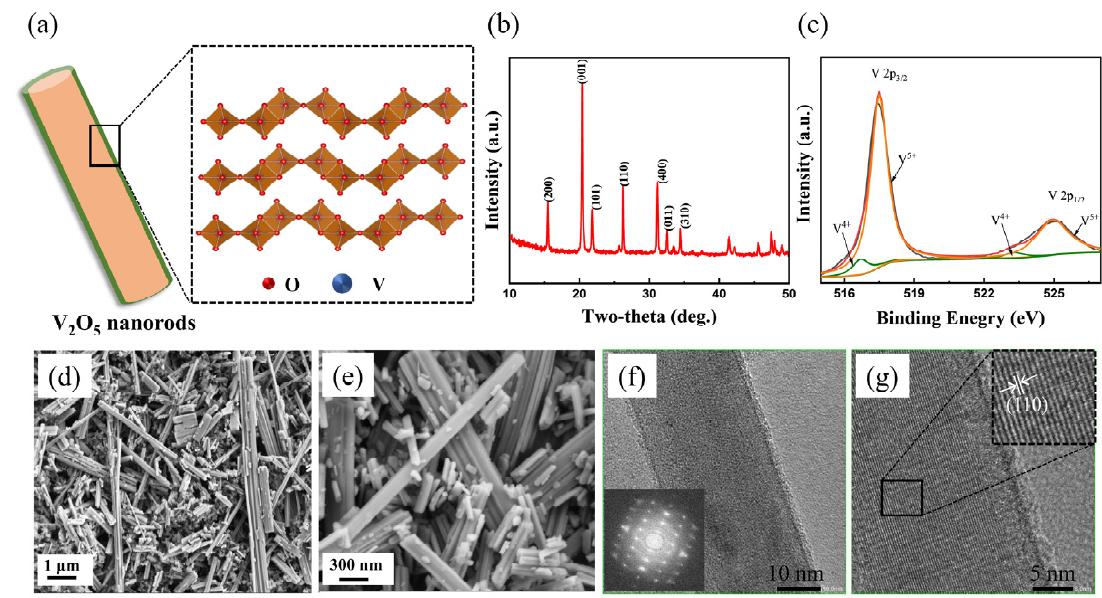
Figure 1. ( a ) Schematic illustration of the orthorhombic V 2 O 5 nanorod structure. XRD pattern ( b ), V 2p XPS spectrum ( c ), SEM images ( d , e ) and TEM images ( f , g ) of the synthesized V 2 O 5 materials.